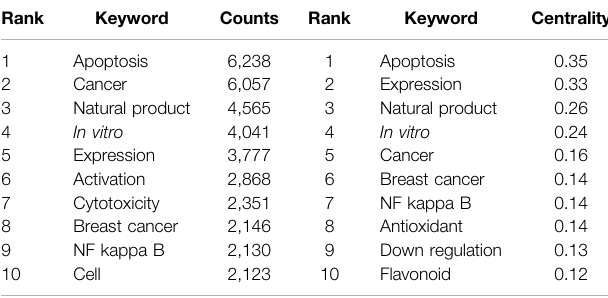
TABLE 8 | The top 10 frequency and centrality of keywords related to natural products in cancer research.